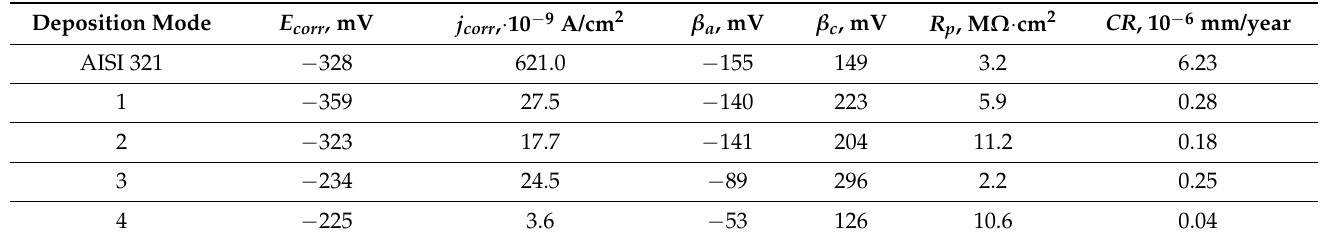
Figure 7. Potentiodynamic curves of Cr coatings obtained on AISI 321 steel substrates depending on their deposition modes. Table 3. Corrosion parameters of Cr